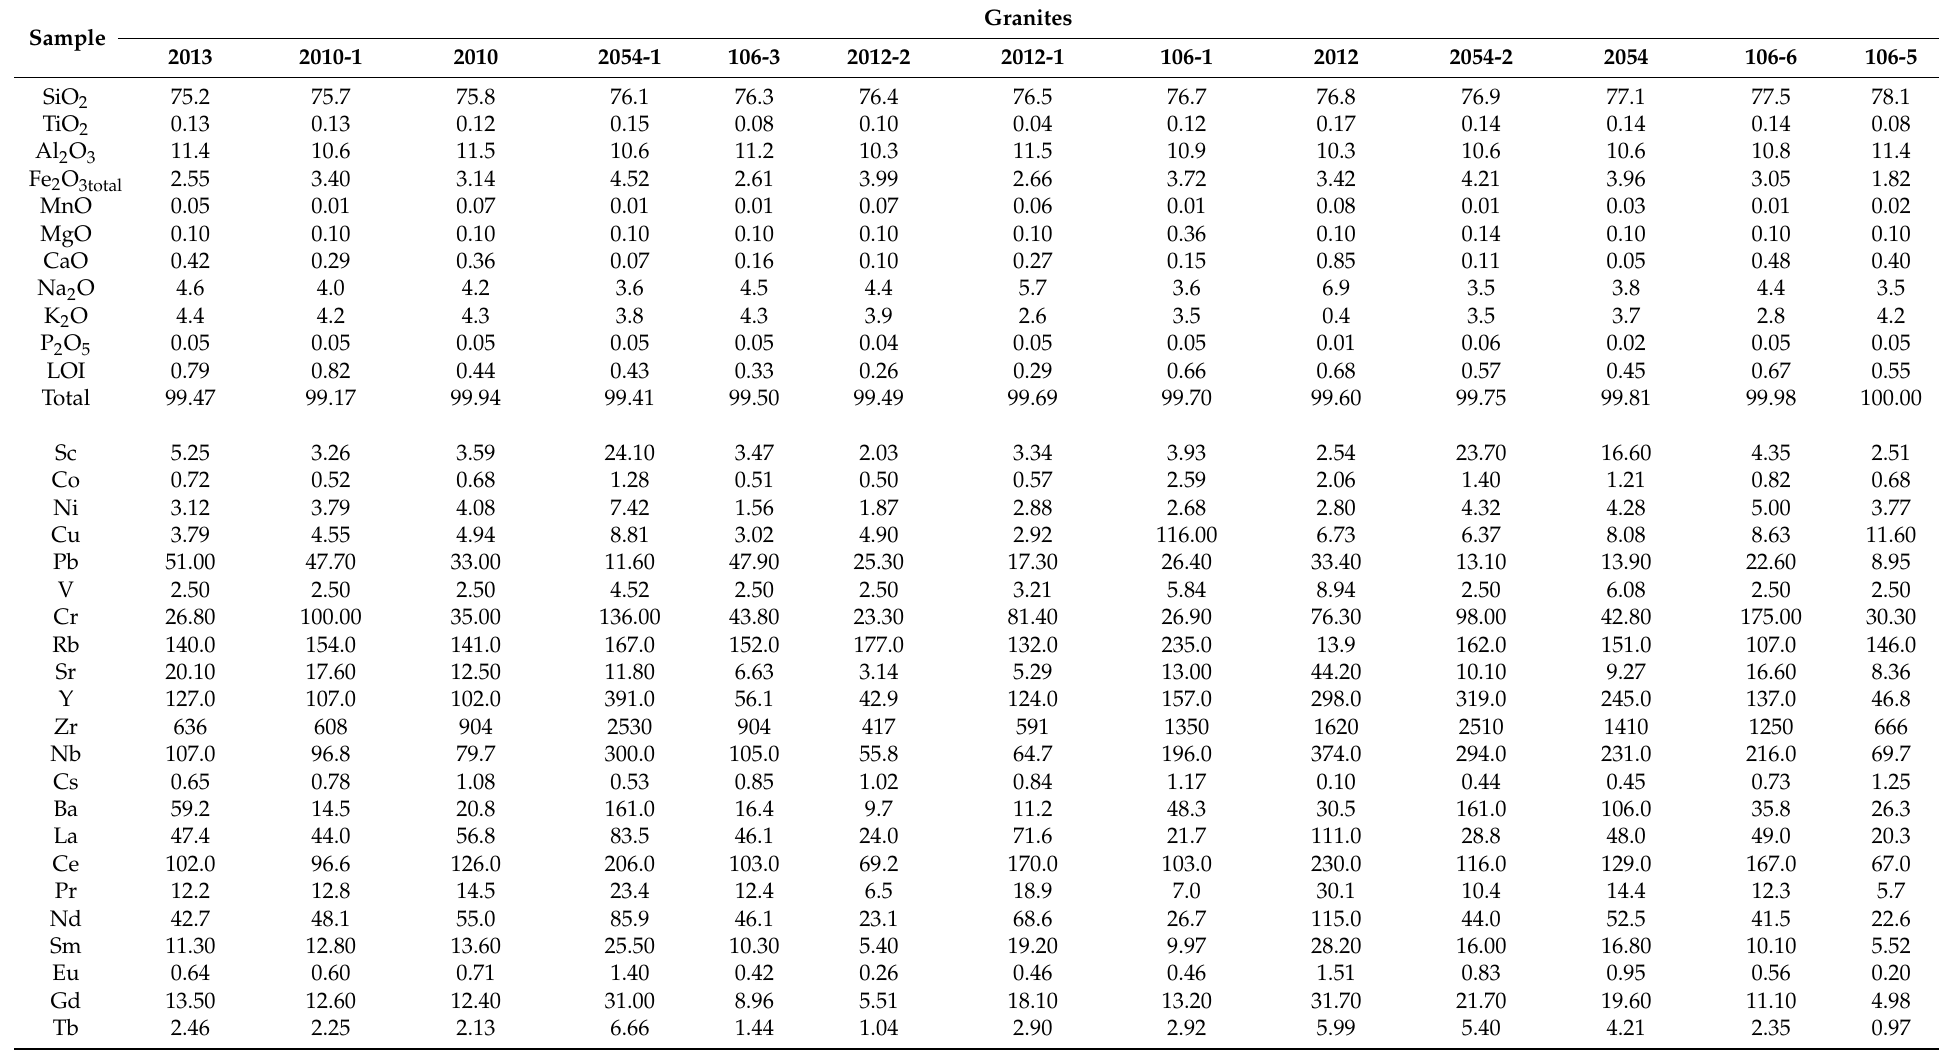
Table 2. Major (in wt %) and trace elements (in ppm) data for the peralkaline granitic and coeval mafic rocks from the Tannuola